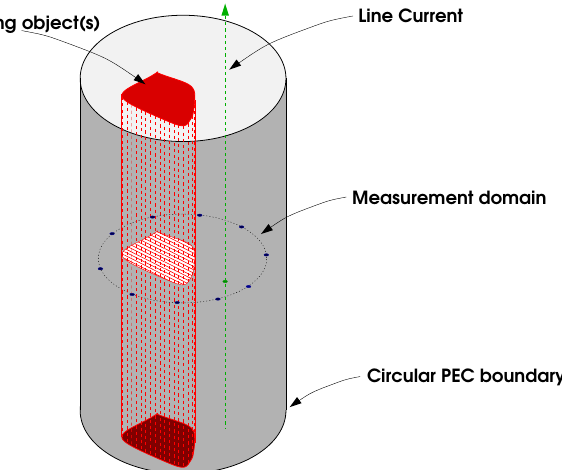
Figure 1. Schematic geometry of the considered